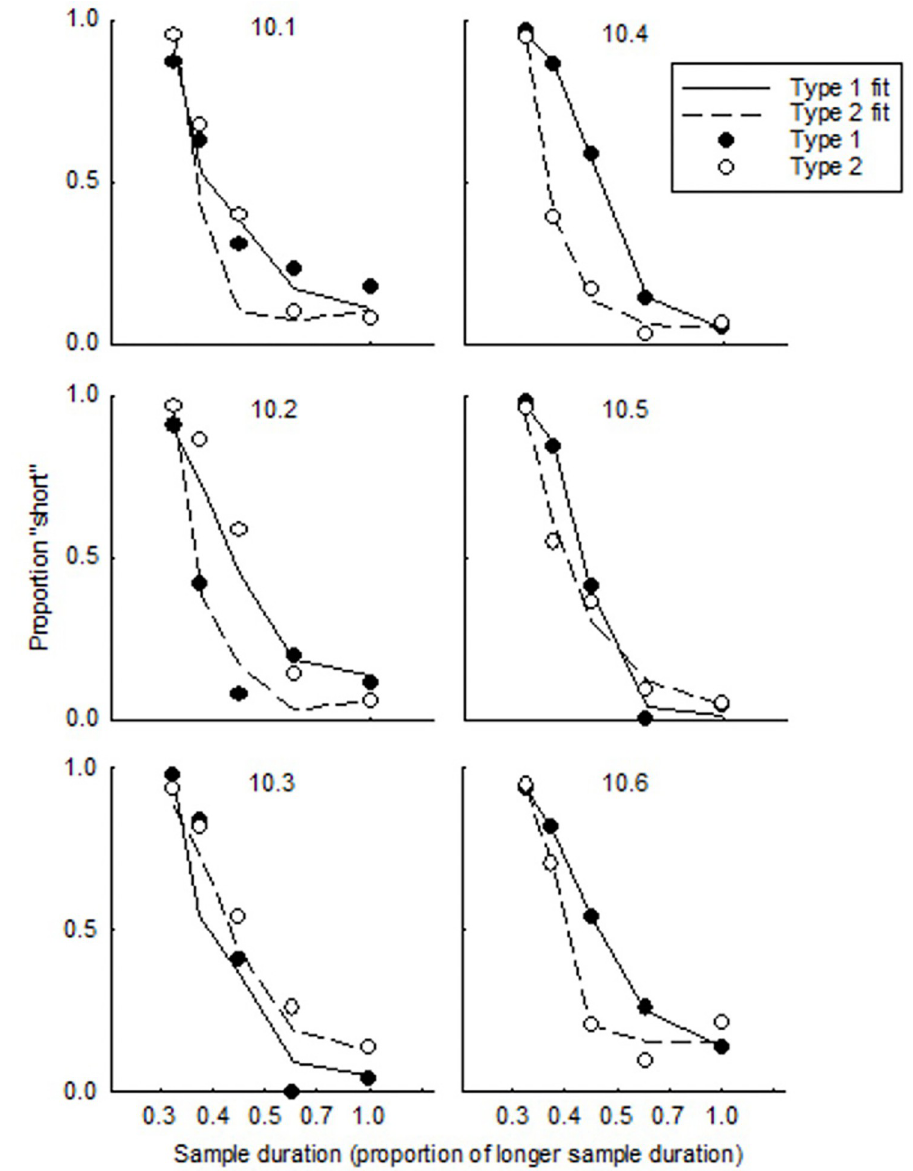
Fig 2. Probability of choosing short in sample tests. Note: Data are plotted as a function of the test sample duration relative to the longer sample-duration used in training. Circles show the proportion of responses made to the comparison stimulus associated with shorter durations during training; lines show the best fits of the logistic function (Eq 1) to the